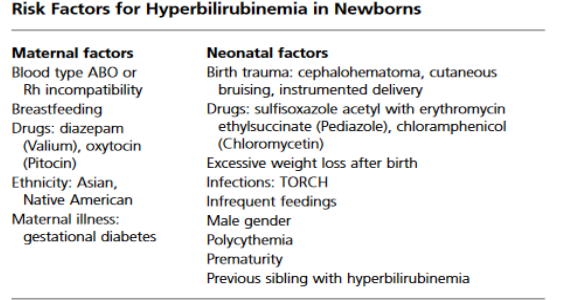
TORCH = toxoplasmosis, other viruses, rubella, cytomegalovirus, herpes (simplex) viruses. Kernicterus refers to the neurologic outcomes caused by unconjugated bilirubin deposition in the brain with damage of the basal ganglia and brainstem nuclei (7). Bilirubin role in kernicterus is not fully understood. When the level of unconjugated